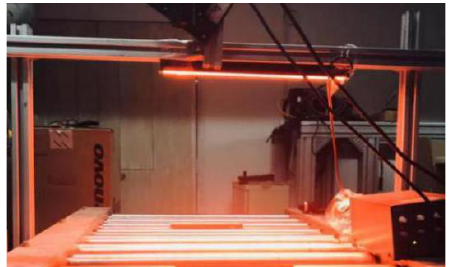
Figure 3. Automatic adjusting light source device.